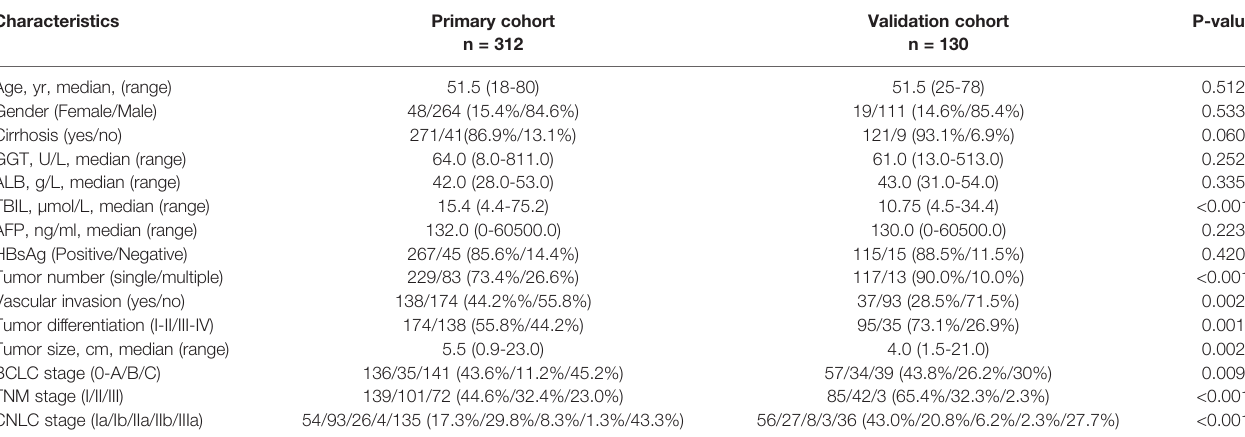
TABLE 1 | Baseline of Patient